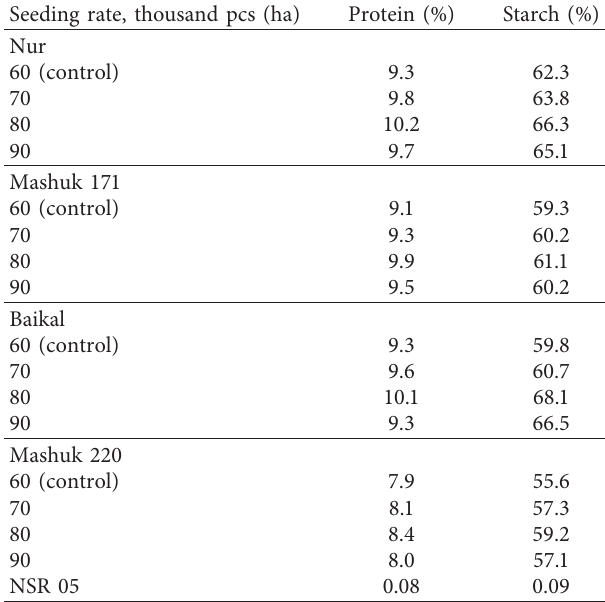
Table 4: The quality of maize hybrids depending on the seeding